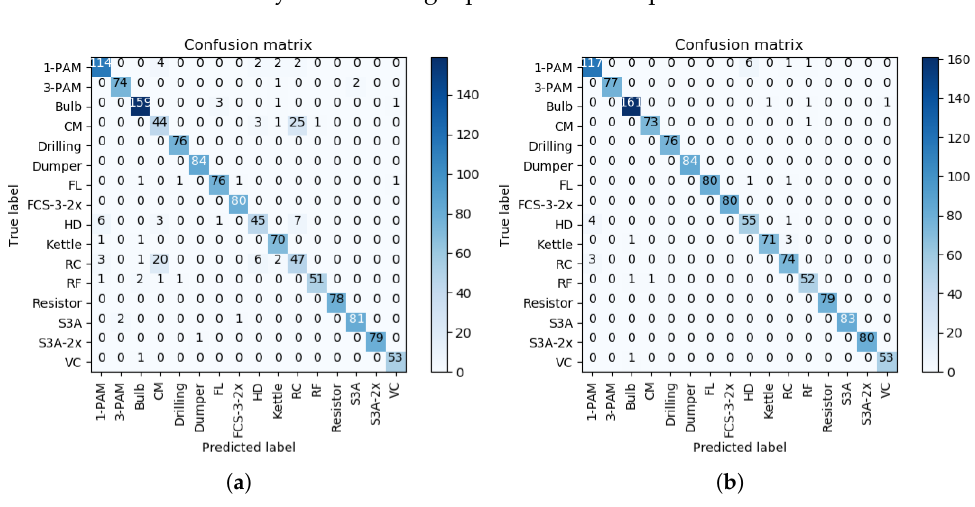
Figure 13. Showing the load identification results obtained by different feature extraction methods for LILACD dataset through confusion matrix. ( a ) Confusion Matrix (LILACD-RP). ( b ) Confusion Matrix